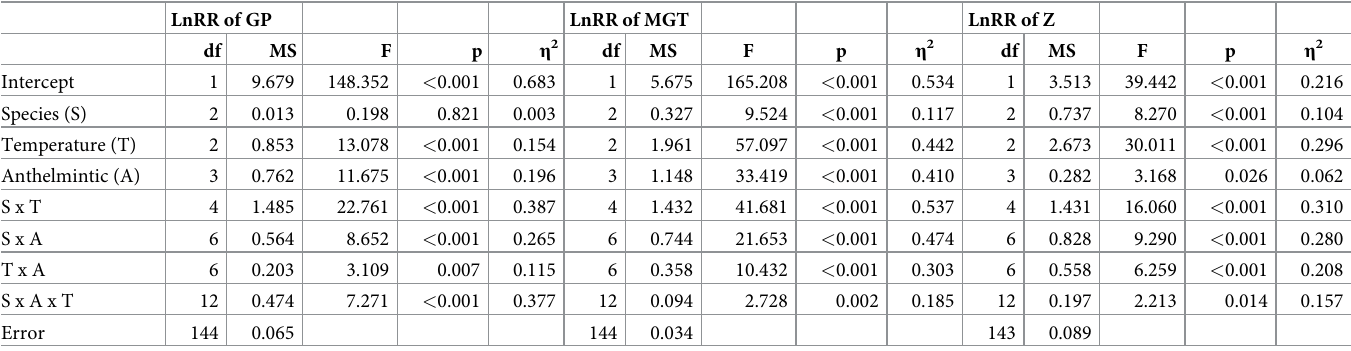
Table 1. Results of ANOVA on the effects of plant species, temperature regime and anthelmintic formulation (Cydectin, moxidectin 0.1%) on natural-logarithm response ratio (LnRR) of germination percentage (GP), mean germination time (MGT) and synchrony of germination (Z). LnRR of GP LnRR of